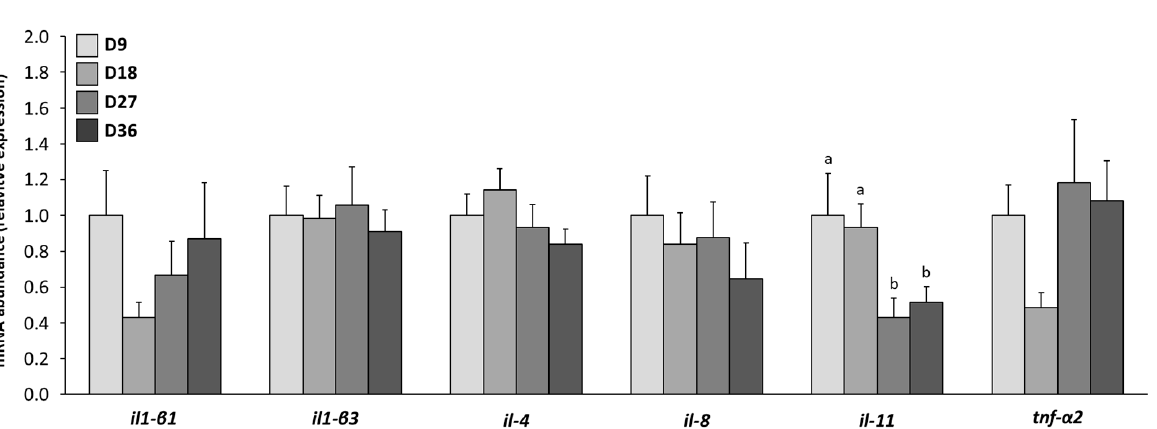
Figure 5. mRNA expression of transcripts related to immune markers and stress response in red blood cells of rainbow trout hand-fed during 12 weeks with different stocking densities. Relative gene expression measured by RT-PCR of irf1, irf1B, irf3, irf4, irf5-1, irf5-2, irf9, hsp30, hsp70 and lyzII in red blood cells of rainbow trout. Values are expressed as group mean ± SEM; fold change vs D9 density for all genes; one-way ANOVA, followed by a post hoc Tukey’s test in case of significant differences ( p < 0.05, indicated with different letters. Mean values that do no share a common letter are significantly different).